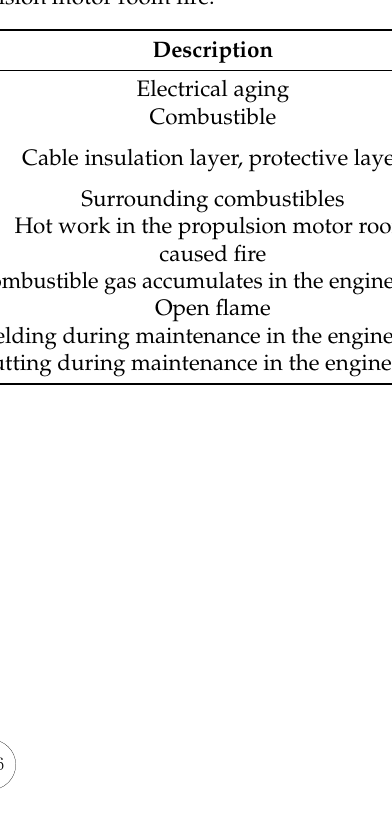
Table 8. Logic gates and principal events of a propulsion motor room fire.